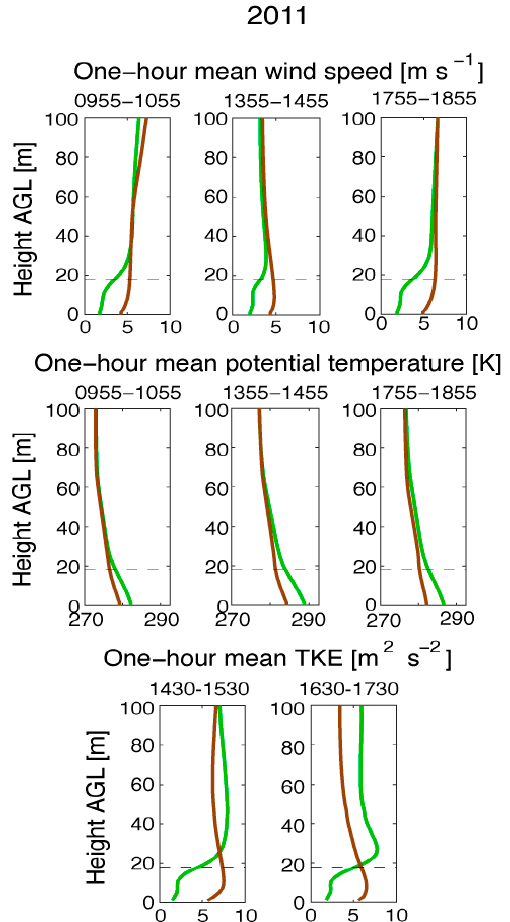
Figure 8. Vertical profiles of time- and space-averaged wind speed, potential temperature, and turbulent kinetic energy (TKE). Averaging is performed across all grid cells for which the fire heat source is applied, during each five-minute period, and then over a one-hour period. Profiles are presented from the control simulation (2011CL; green line) and the no-canopy simulation (2011NC; brown line). The TKE is total TKE (resolved + subgrid-scale). Note that the time period for the TKE panels differs from the wind speed and potential temperature panels. Dashed horizontal lines in each panel depict the average canopy height across the burn unit (Figure 1c).